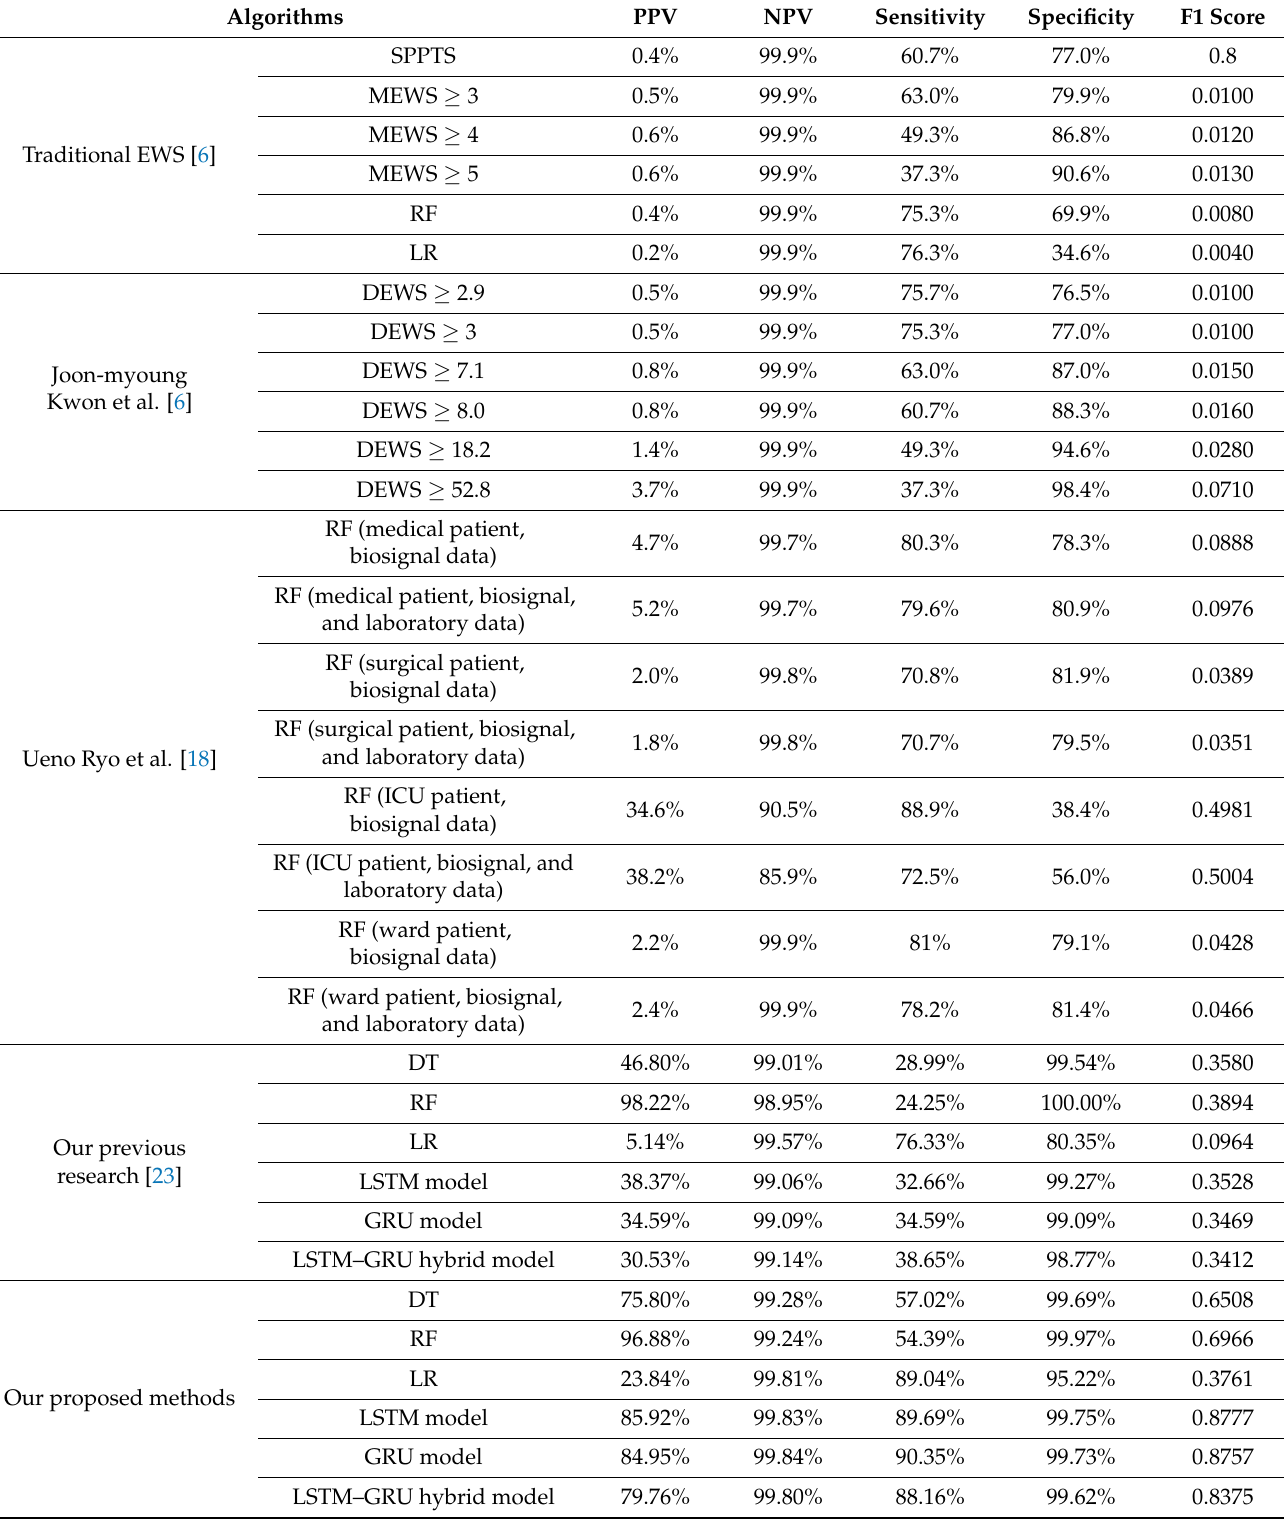
Table 10. Comparison of performance with previous studies for predicting in-hospital cardiac